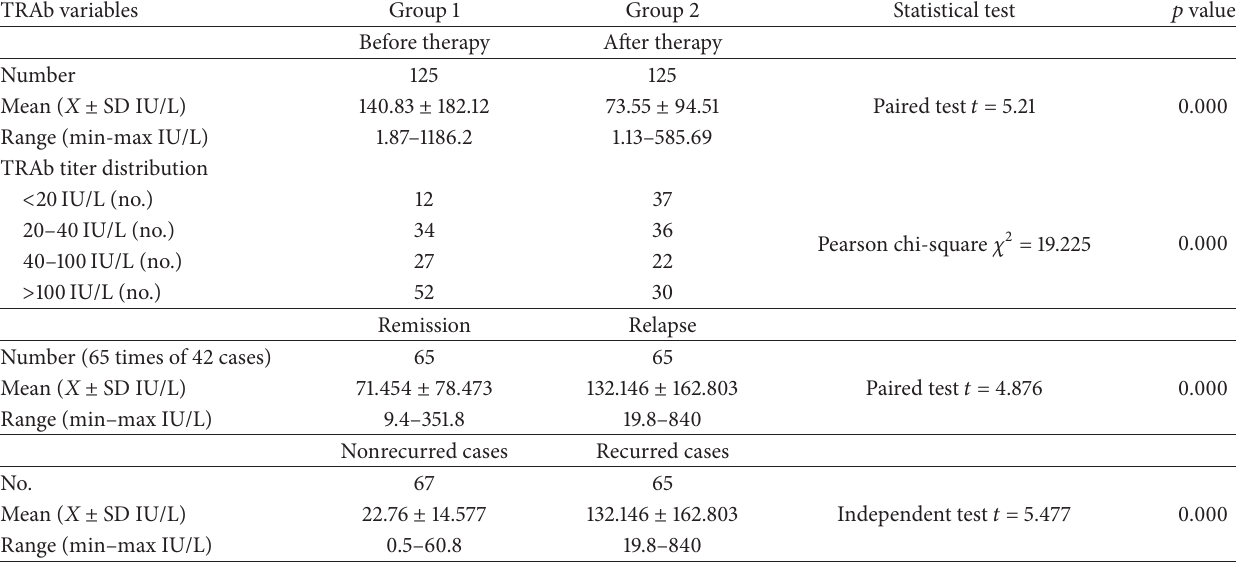
Table 5: Comparison of TRAb titers between before and after therapy, remission and relapse, and recurred and nonrecurred cases.